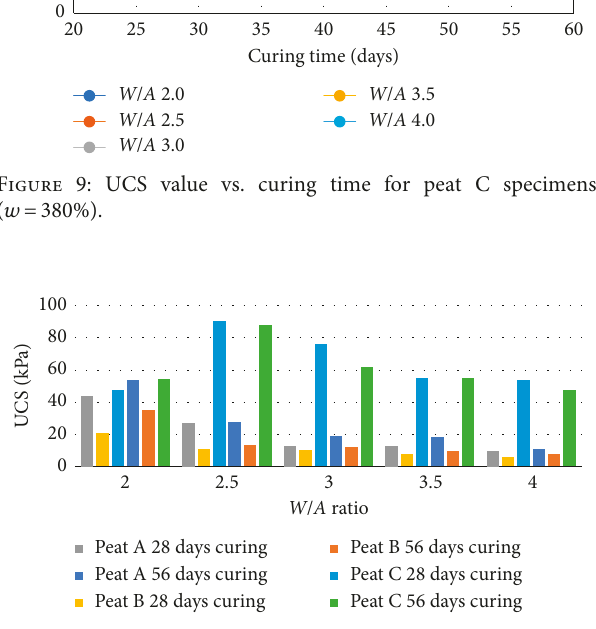
Figure 10: UCS value vs. W / A ratio for each specimen.